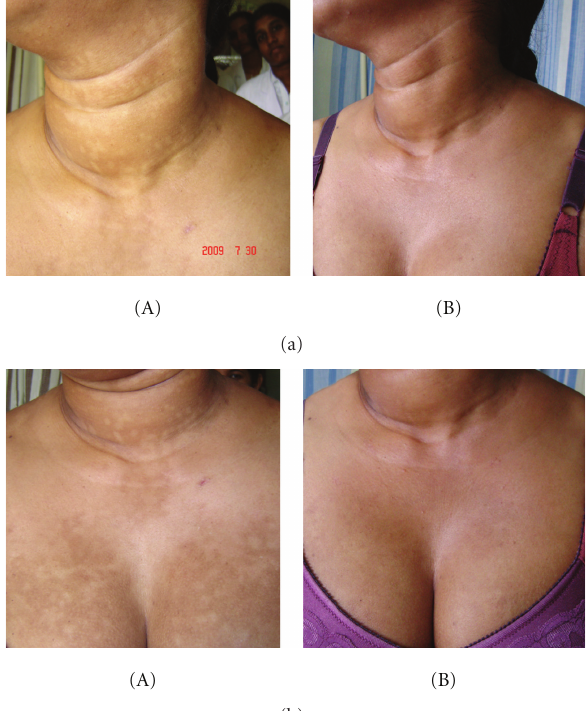
Figure 4: (a) A 30-year-old woman had hypopigmented patches on sunlight covered body sites. Note these patches extend to neck and (b) breast which is less likely in progressive macular hypomelanosis. (A) before therapy (B) showing almost complete clinical response after 40 sessions of narrow-band UVB. Note some hypopigmented lesions persist under the chin and neck (patient